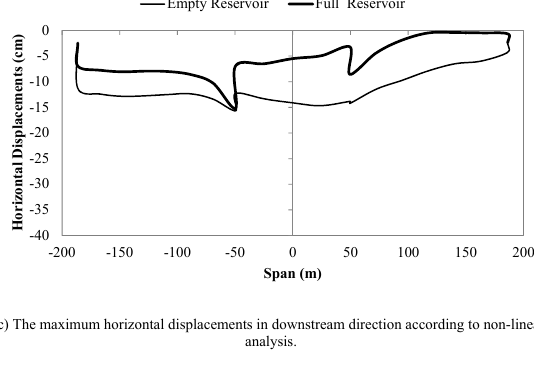
b) The maximum horizontal displacements in upstream direction according to linear analysis.